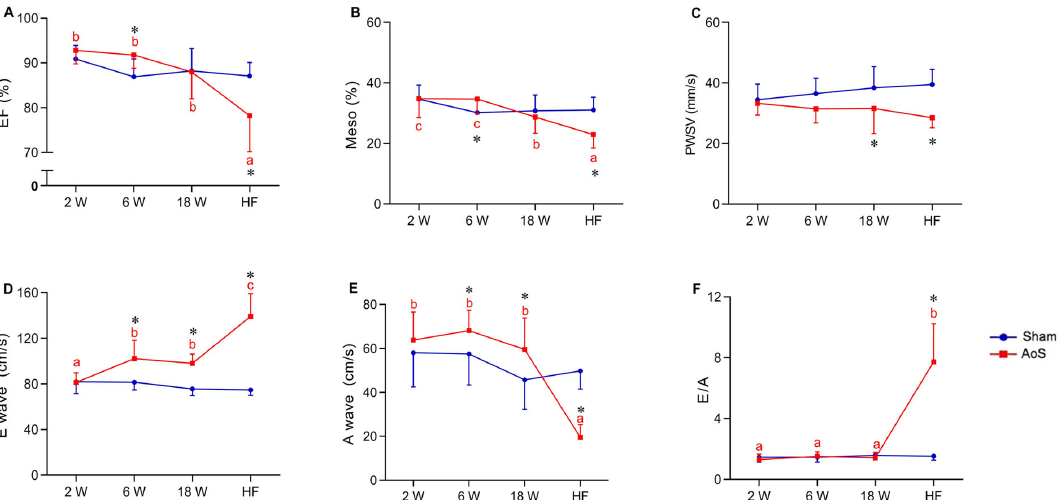
Figure 3. Functional echocardiographic data at different euthanasia moments (2, 6, 18 weeks [W] and heart failure [HF]). Sham: operated control (blue); AoS: supravalvar aortic stenosis (red). ( A ) EF (%): left ventricle (LV) ejection fraction in percentage. ( B ) Meso (%): LV shortening of mesocardium in percentage. ( C ) LVPW: LV posterior wall shortening velocity. ( D ) E wave: early diastolic mitral inflow velocity. ( E ) A wave: late diastolic mitral inflow velocity. ( F ) E/A: ratio between E wave and A wave. Data are expressed as mean ± SD and analyzed by ANOVA and Tukey. p < 0.05. * AoS vs. respective Sham. Distinct letters signify statistical difference between moments; ( n = 12–18 animals for each group).